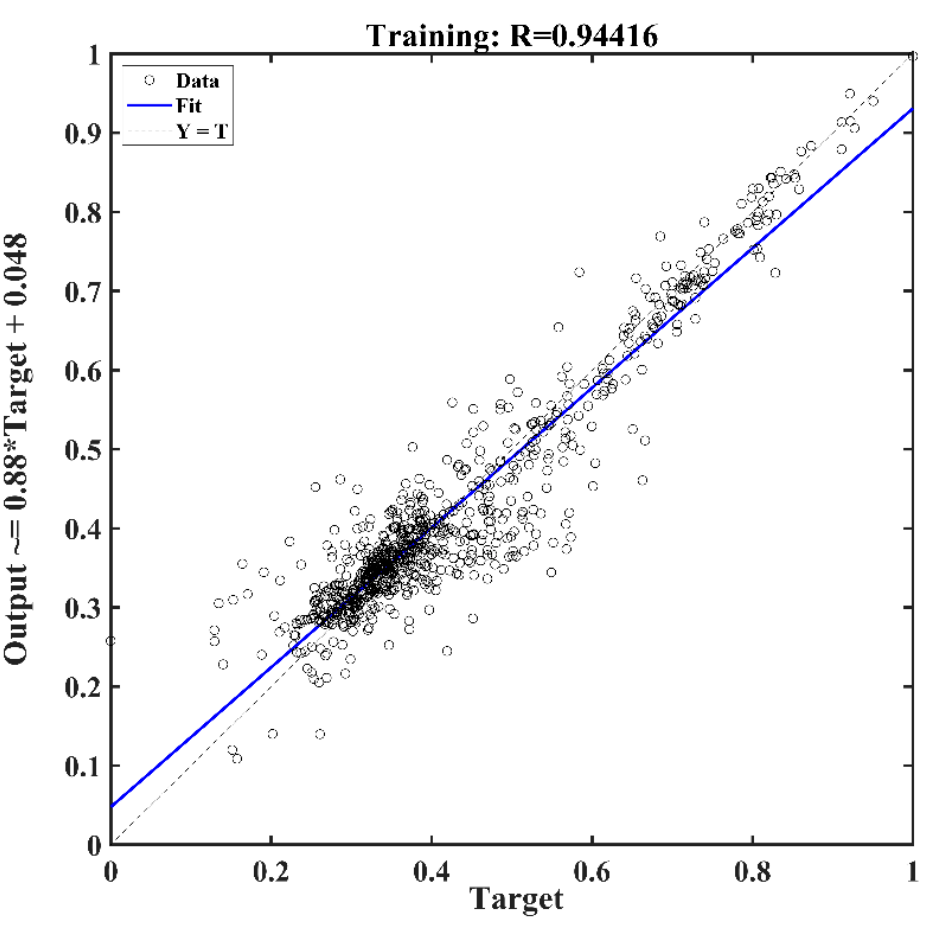
Figure 14. Process diagram of BP neural network.